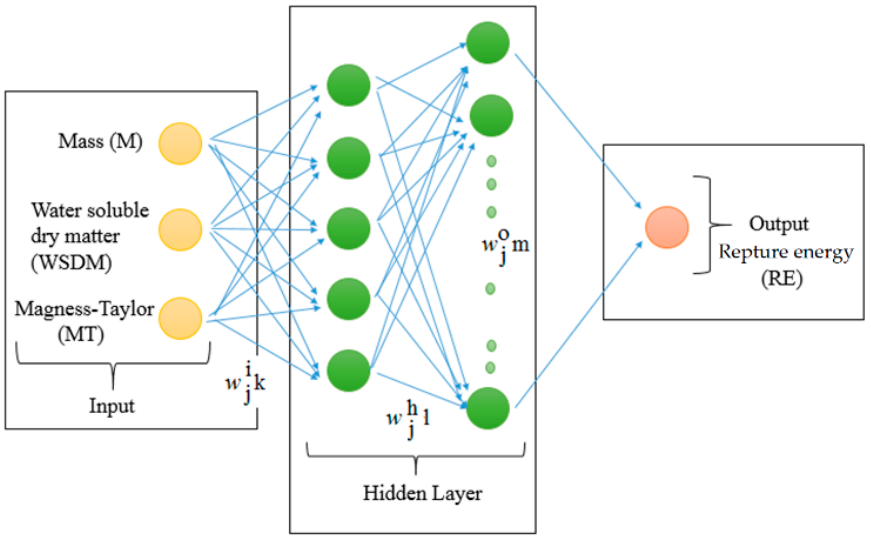
Figure 1. Artificial neural network multi-layer structure with 3-5-8-1 for rupture energy prediction.